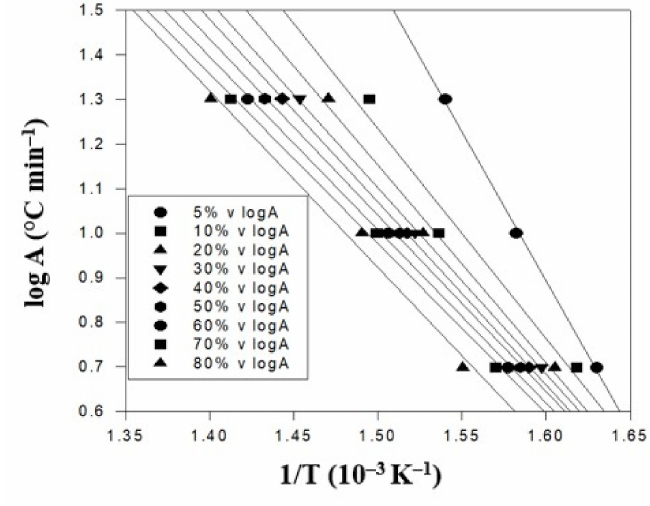
Figure 5. TGA thermal degradation analysis results of the PBT–EVOH polymer composite film using no triallylamine crosslinking agent. Table 1. The corresponding thermal analysis results of the PBT–EVOH polymer composite film using no triallylamine crosslinking